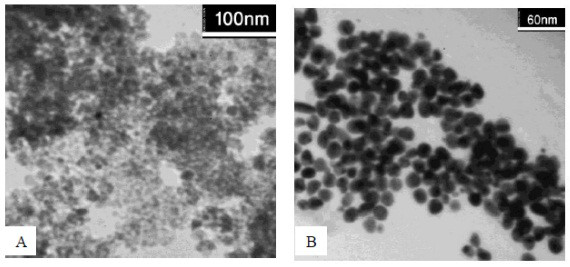
TEM images of Fe3O4 nanoparticles (A), and core-shell Fe3O4-Au nanoparticles stabilized using chitosan (B).